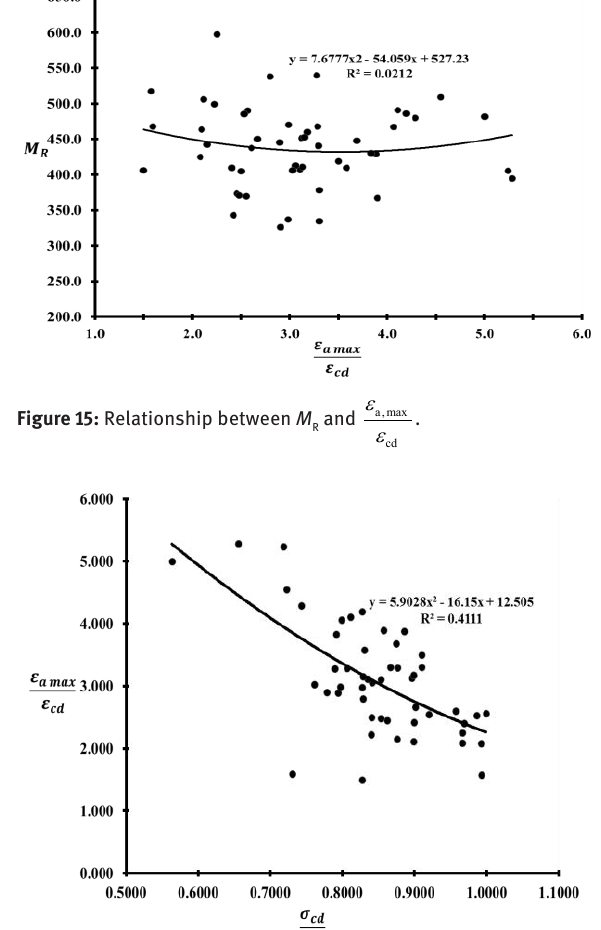
Fig. 14. Relationship between and 𝜎𝜎 𝑐𝑐𝑐𝑐 Fig. 16. Relationship between and 𝑀𝑀 𝑅𝑅 𝜎𝜎 𝑐𝑐 𝜀𝜀 𝑎𝑎 (cid:3) 𝑚𝑚𝑎𝑎𝑚𝑚 𝜎𝜎 𝑐𝑐𝑐𝑐 Fig. 18. Relationship between M 𝜎𝜎 𝑐𝑐 𝜀𝜀 𝑐𝑐𝑐𝑐 initiation strain ( 